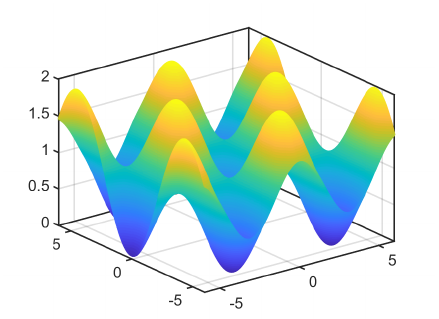
Figure 5. The figure of function f 3